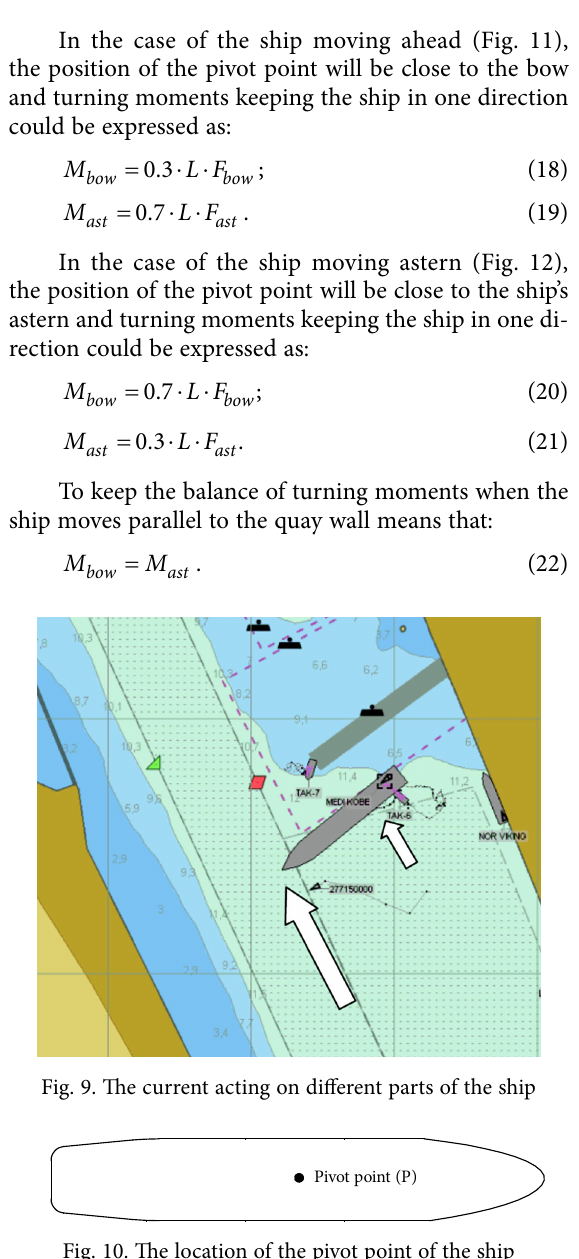
Fig. 10. The location of the pivot point of the ship in the stop position